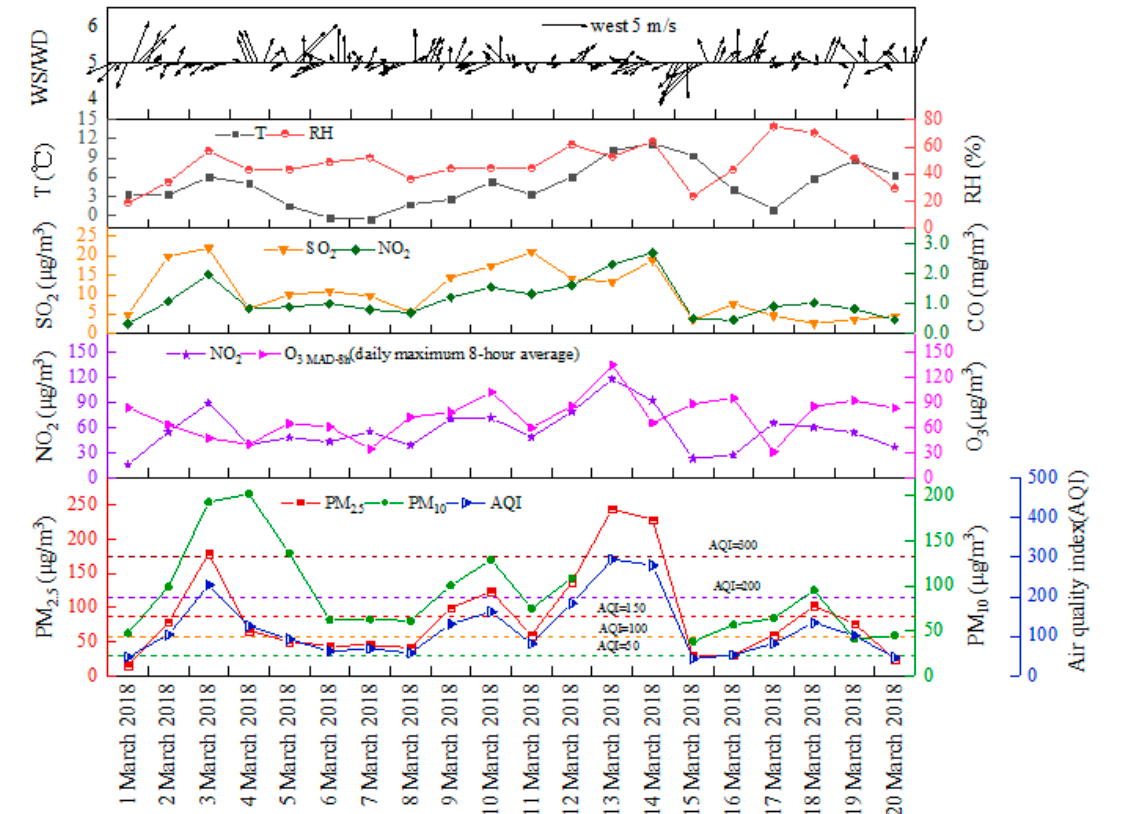
Figure 2. Daily variation of the concentration of PM 10 , PM 2.5 , SO 2 , NO 2 , CO, O 3 , ambient air quality index (AQI), and meteorological conditions in the study area during the monitoring period.